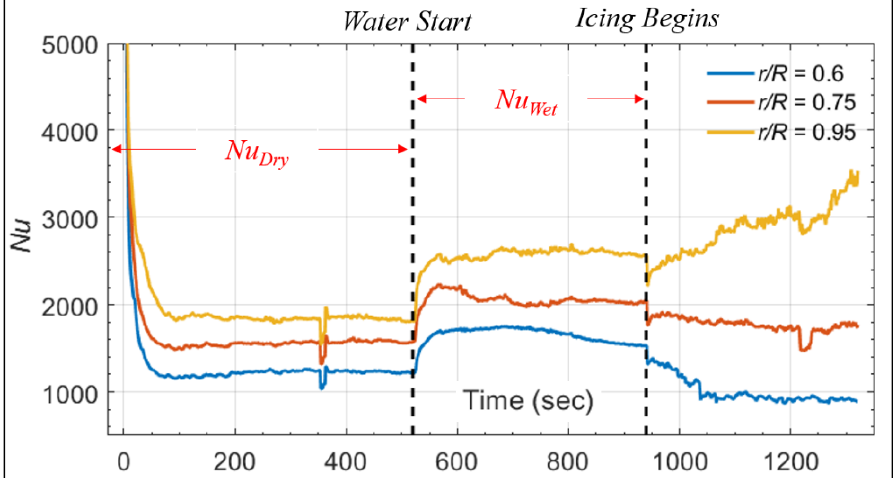
Figure 6. Instantaneous Variation in the Nu(t) for the Anti-Icing Test at T ∝ = 265.65 K for Ω = 500 RPM and V ∝ = 20 m/s (Test #9).